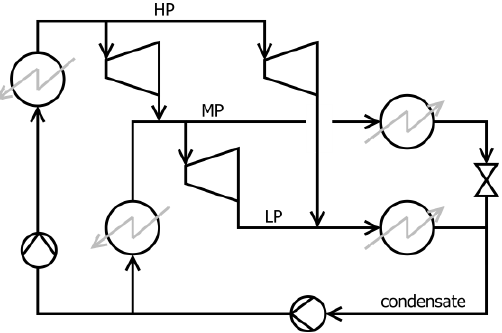
Figure A3. Example of simple steam network used in large process industrial sites.